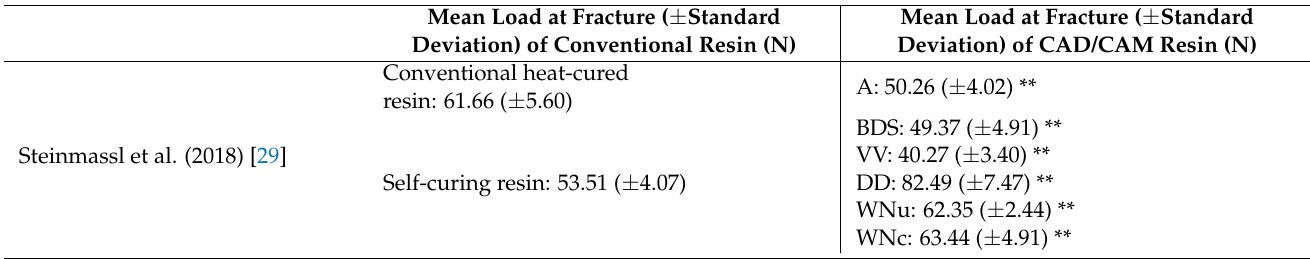
Table 3. Breaking load test